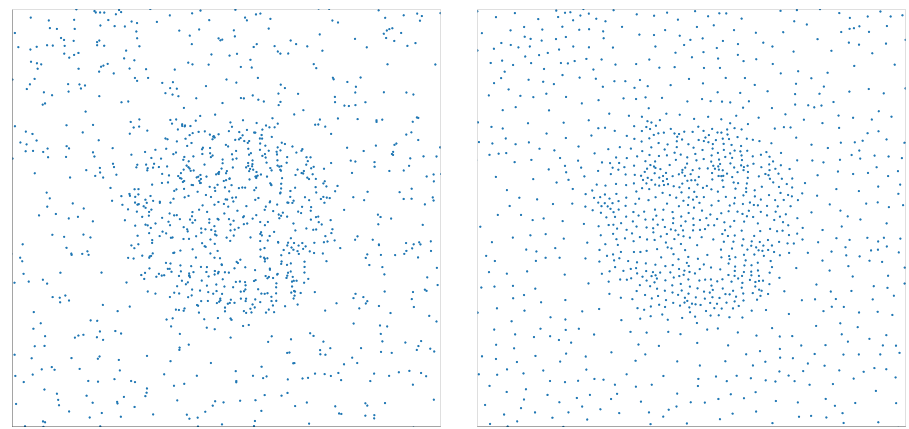
Figure 24 . The point data for the circular boundary example considered in section 7.2.1. The left panel shows the original N = 1000 points distributed according to (2.7) with ρ = 5 . The right panel shows the same data after 1 Lloyd